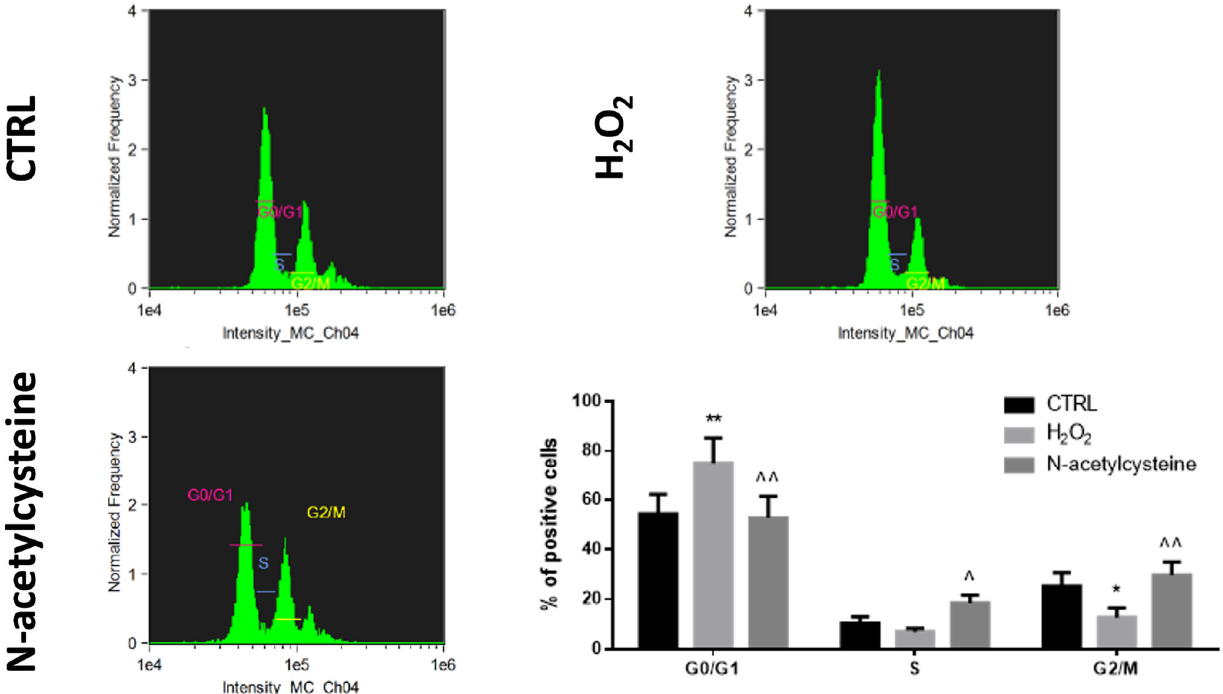
Figure 3. Cell cycle analysis in confluent HepaRG cells exposed to vehicle (CTRL), 100 μ M H 2 O 2 , or 1 mM N-acetylcysteine every 24 h for 5 days. In the bar graph, data are illustrated as mean ± SEM of three replicates. Statistical differences were analyzed by one-way ANOVA; Tukey–Kramer was used as post hoc test. * = p < 0.05 vs. CTRL; ** = p < 0.01 vs. CTRL; ^ = p < 0.05 vs. H 2 O 2 ; ^^ = p < 0.01 vs. H 2 O 2 .